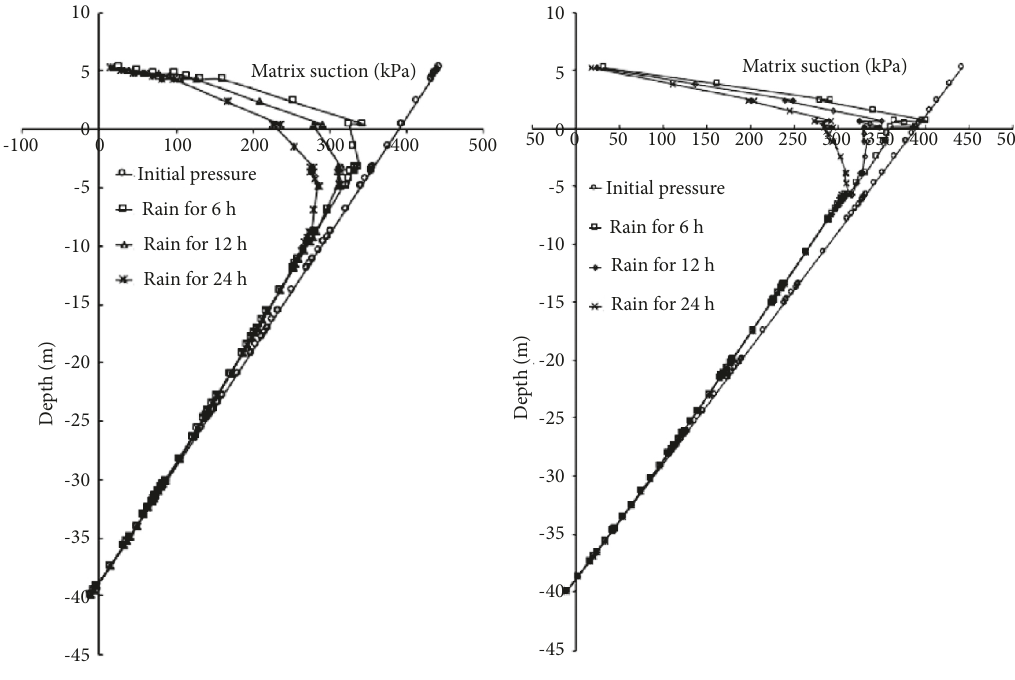
Figure 7: Variation of rainfall infiltration suction depth.